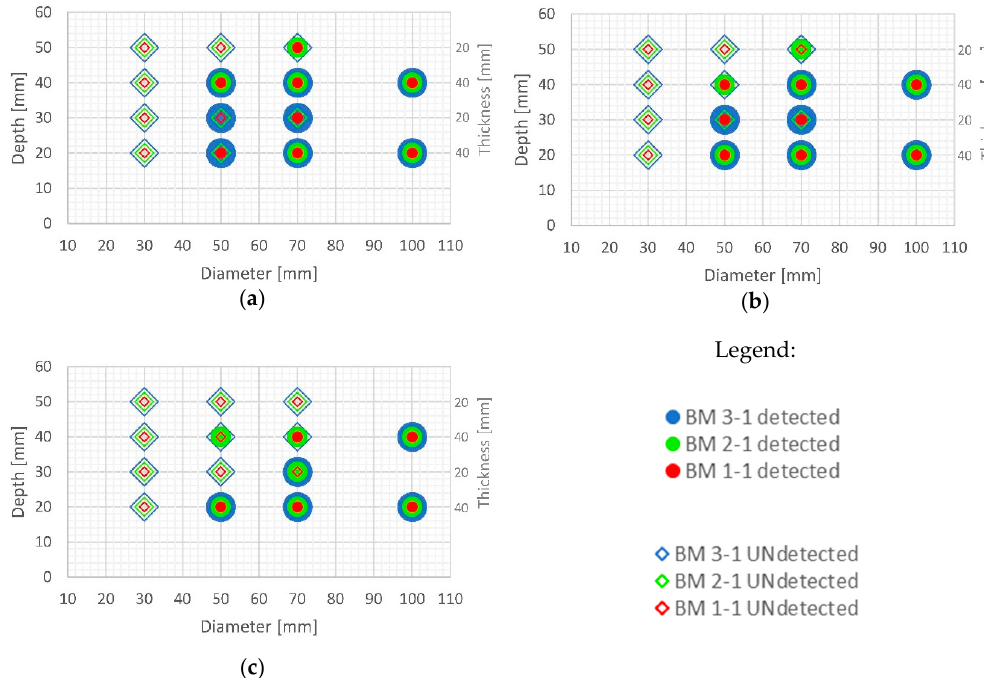
Figure 16. Possibility of defect detection overview for samples BM x-1 (all three concrete types) using PCT: ( a ) excitation distance 1.5 m; ( b ) excitation distance 2 m; ( c ) excitation distance 3 m.